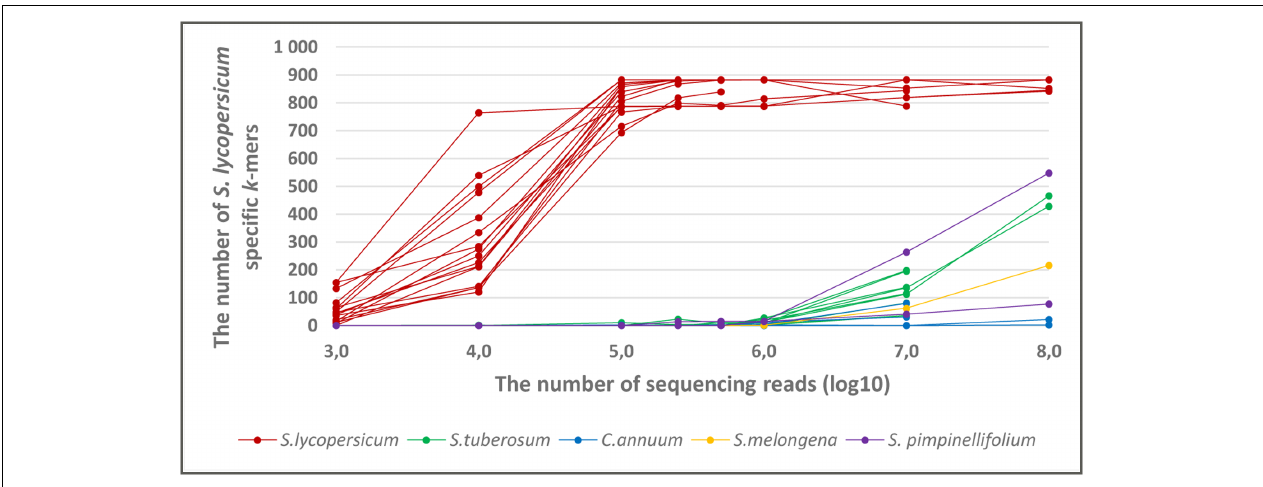
FIGURE 5 | The number of detected S. lycopersicum specific k -mers in the whole genome sequencing raw data from S. lycopersicum, S. pimpinellifolium , S. tuberosum, Solanum melongena, and Capsicum annuum with variable number of sequencing reads (10 2 –10 8 ). The set of taxon-specific k -mers contains 882 k -mers that were present in at least 2 S. lycopersicum chloroplast sequence. The samples from the S. lycopersicum target species are marked with a red color, and the non-target species are in different colors.